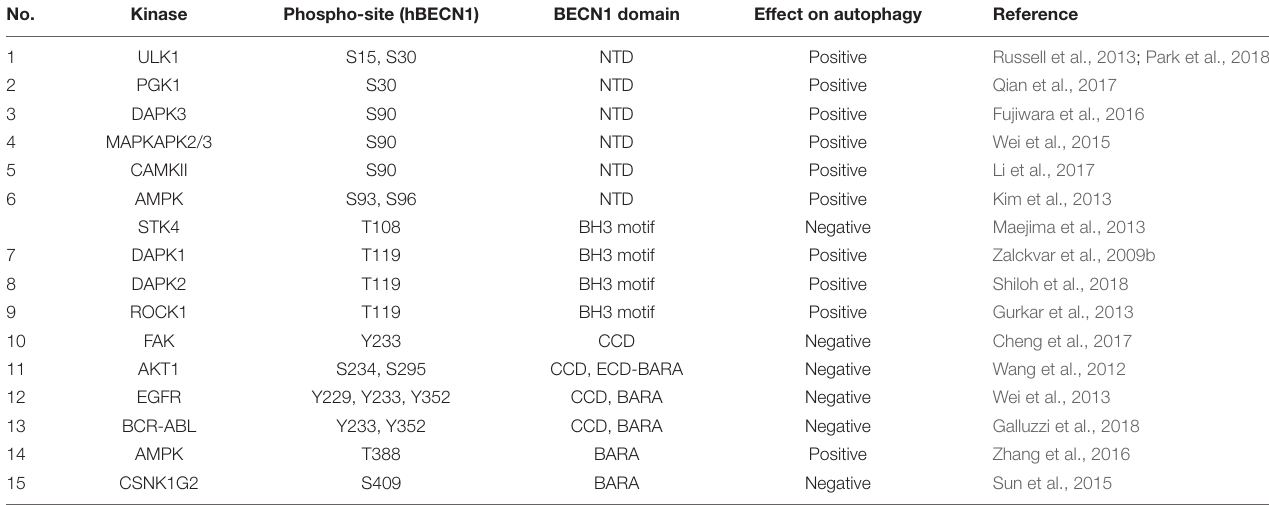
TABLE 1 | Beclin 1 (BECN1) phosphorylation sites, their domain localization, effect on autophagy and the kinases involved.